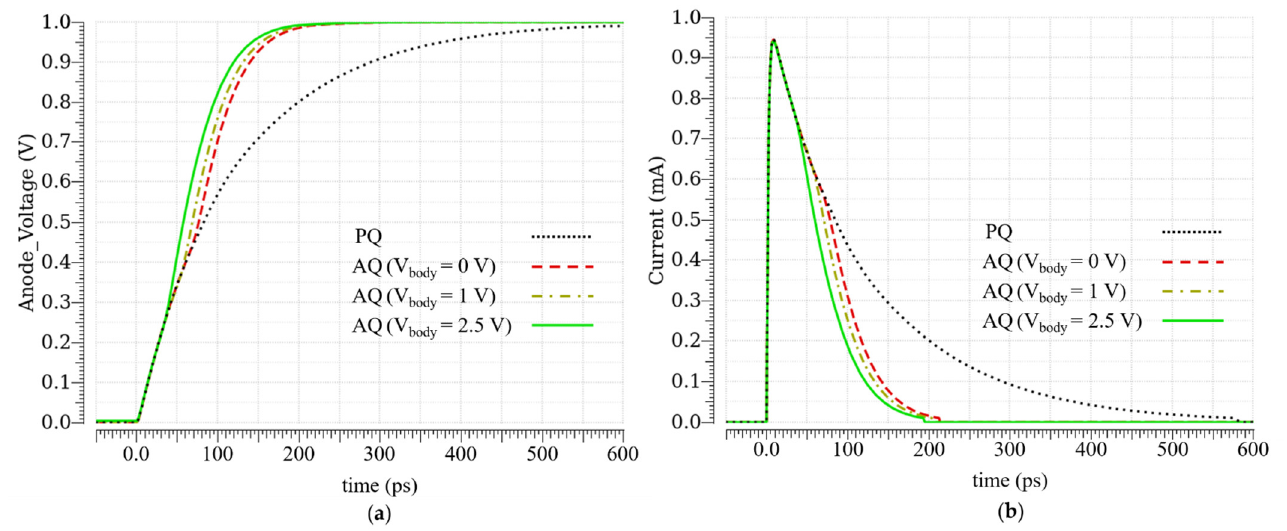
Figure 6. Post-layout simulation results in the PQ and the AQ: ( a ) anode voltage; ( b ) avalanche current.